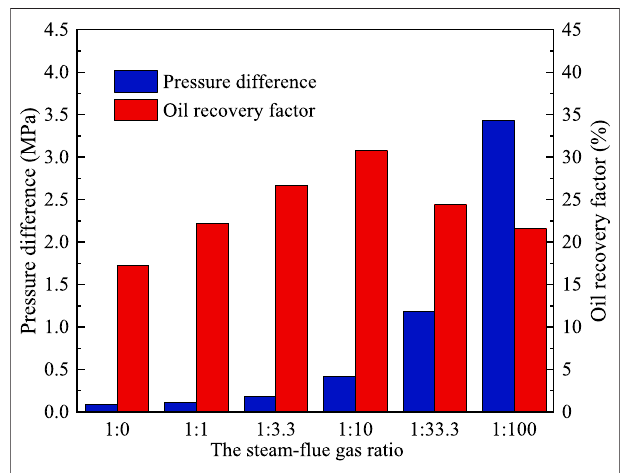
FIGURE 7 | Changes in fi nal oil recovery factor and maximum back pressure increase under different steam- fl ue gas ratios.